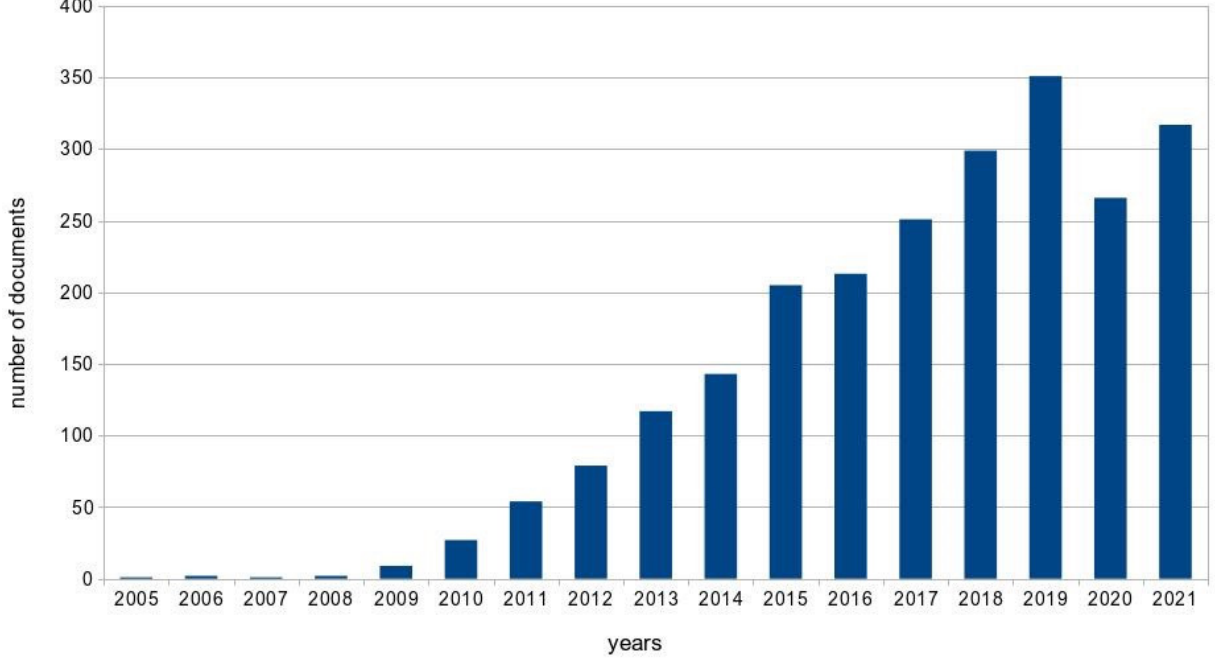
Figure 1. Number of documents per year.